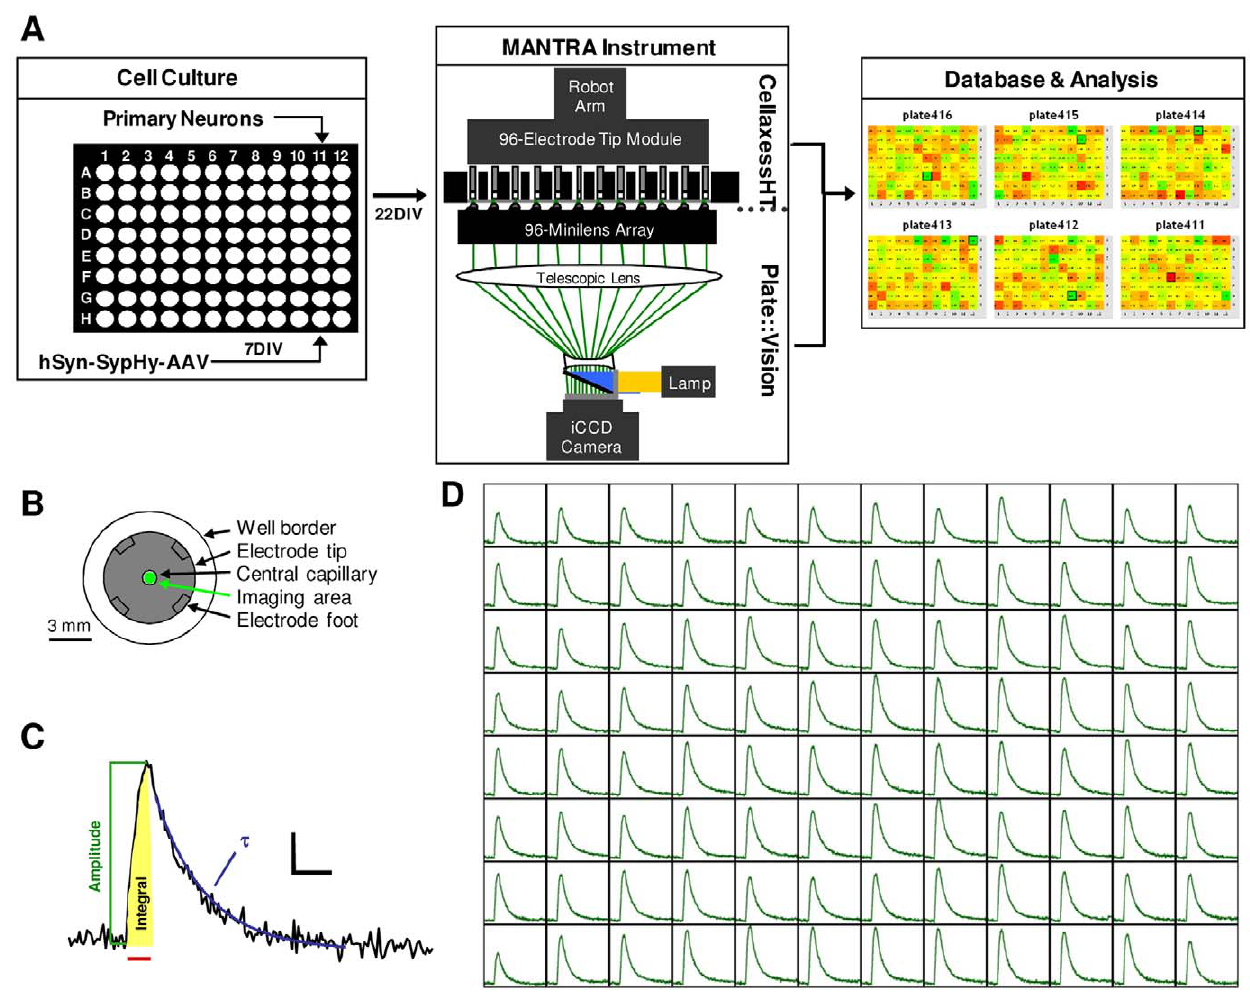
Figure 2. The MANTRA system. ( A ) Schematic depicting the MANTRA system, including the cell culture system, the reporter system, the instrumentation, and the heatmap application of the data analysis system. ( B ) Schematic depicting the relative dimensions of an electrode tip and the imaging area within a single well of a 96-well plate. ( C ) Representative sypHy fluorescence trace from a single well when stimulated as in (D) showing three of the basic waveform features automatically extracted by the MANTRA system analysis software. Red bar indicates stimulus. Scale bar: 0.05 D F/F, 20 sec. ( D ) Representative dataset from the MANTRA system showing sypHy fluorescence responses to a 50 Hz, 15 sec stimulus train from all wells of a 96-well plate. For each well, y-axis: 0.35 D F/F, x-axis: 180